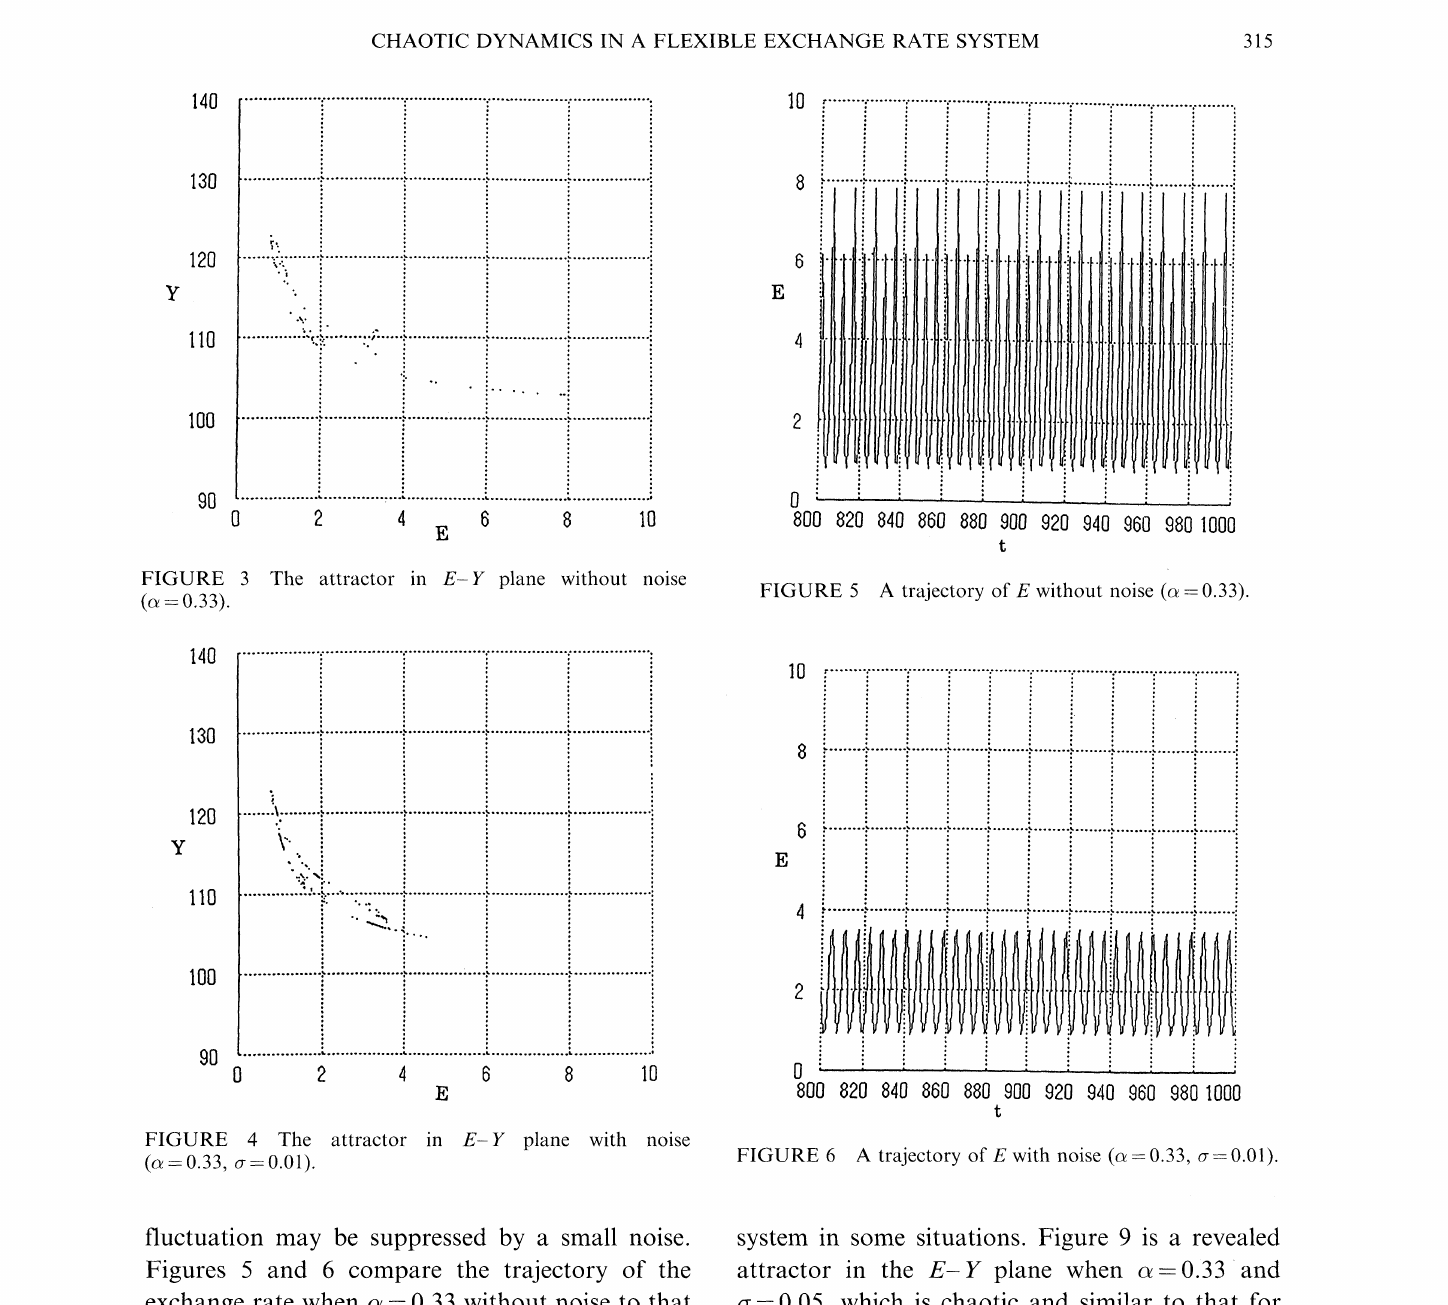
FIGURE 3 The attractor in E-Y plane without noise ( =0.33).